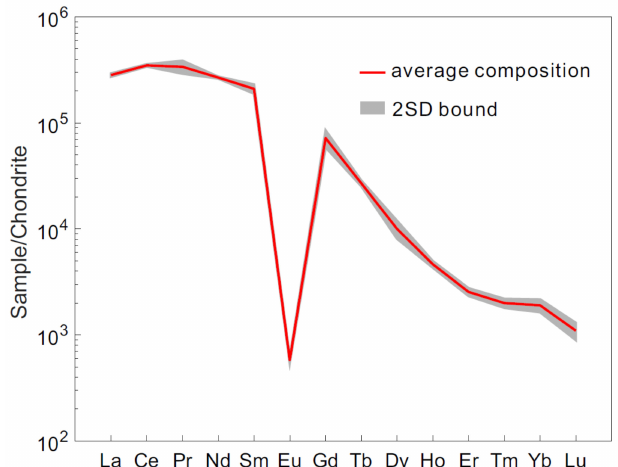
Figure 3. Chondrite-normalized [38] rare earth element (REE) patterns of the RW-1 monazite. The major elements are determined by electron probe microanalysis (EPMA) and trace elements by laser ablation-inductively coupled plasma-mass spectrometry (LA-ICPMS).